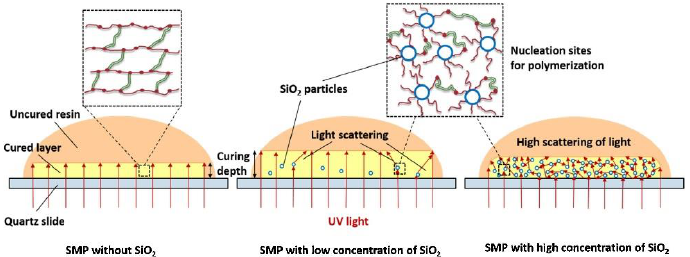
Figure 17. Schematic diagram of nanosilica acting as nucleation spots to initiate polymerization [63]. Copyright © 2022 Elsevier.